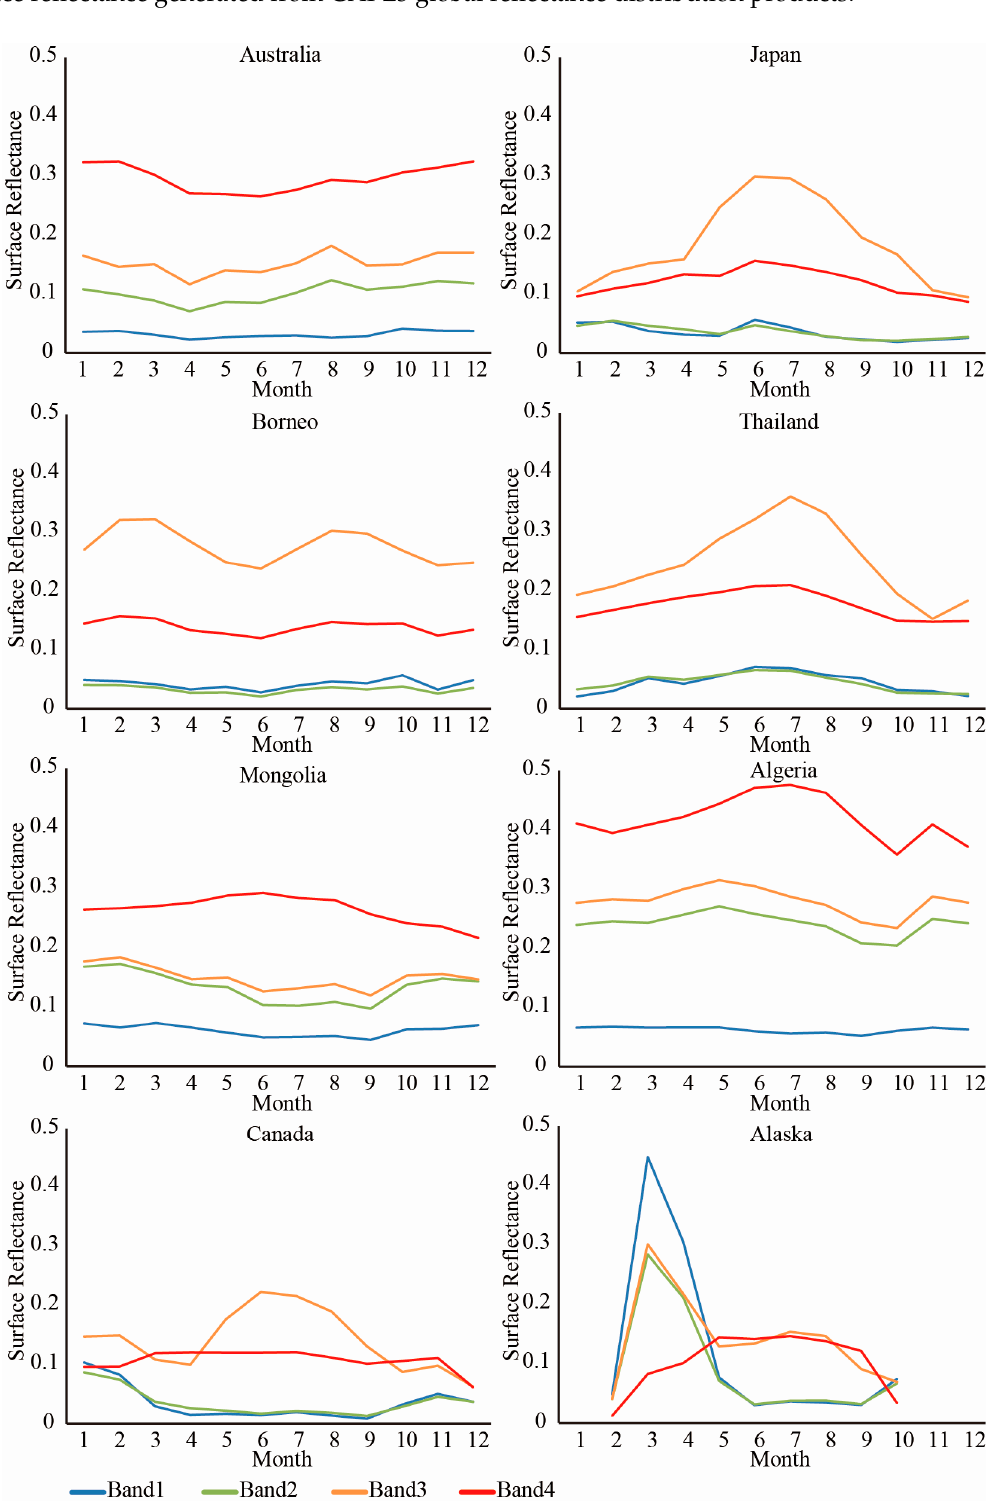
Figure 4. Change of surface reflectance in each band (Band 1: 0.38 nm; Band 2: 0.67 nm; Band 3: 0.87 nm; Band 4: 1.6 μ m).